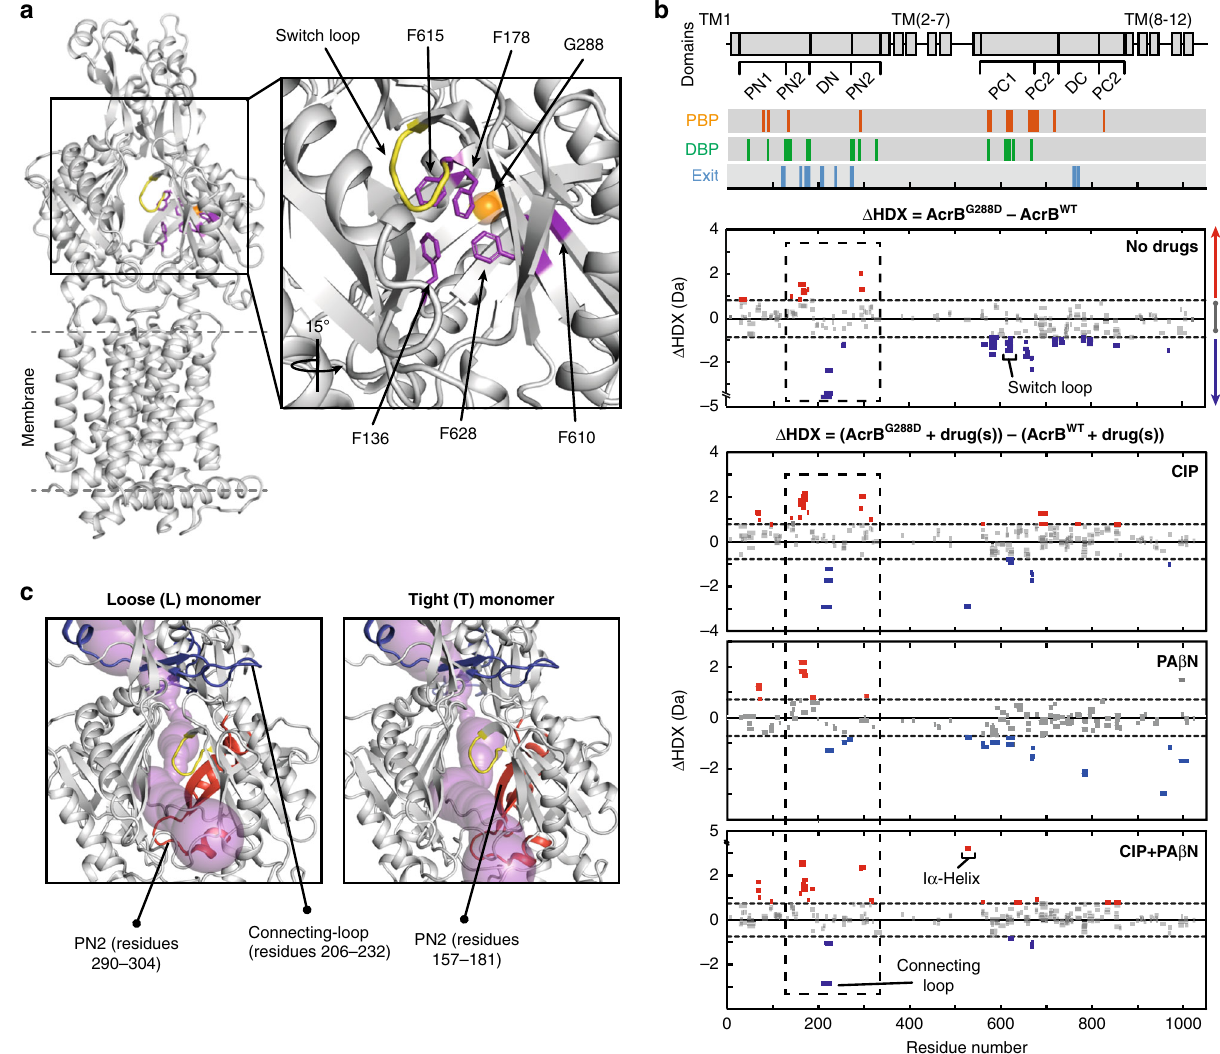
Fig. 4 In fl uence of MDR mutation G288D on AcrB structural dynamics. a In this zoom-in view of the DBP, within the L-state monomer of AcrB (PDB:2HRT), the G288 position is shown as an orange sphere amongst the hydrophobic trap (purple) and alongside the switch loop (yellow). b Differential HDX ( Δ HDX) plots for AcrB G288D and AcrB WT with and without drugs. All data reported as in Fig. 2. 98% con fi dence intervals are shown as grey dotted lines and grey data are peptides with insigni fi cant Δ HDX. All measurements were performed at least in triplicate. All supporting HDX-MS peptide data can be found in the Source Data fi le. ( c ) Shared regions surrounding the DBP whose HDX are increased (red) and decreased (blue) in a substrate-independent manner (highlighted by the dashed boxes in Fig. 4b) are shown on both L- and T-state monomers of AcrB (PDB:2HRT). The connecting-loop from the adjacent monomer is included. Substrate ef fl ux pathways (magenta) for the periplasmic entrance are depicted using CAVER 68